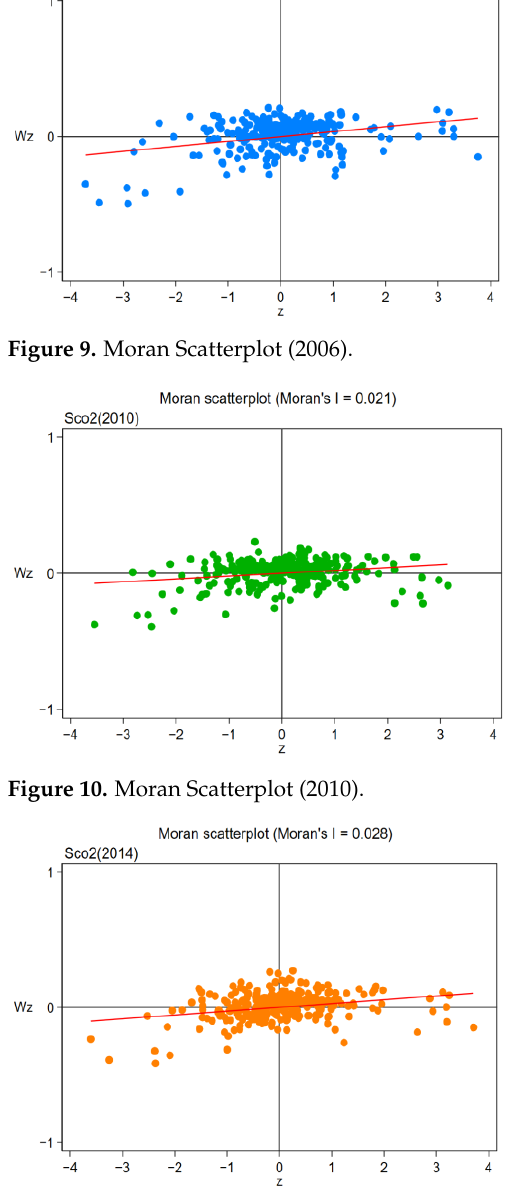
Figure 12. Moran Scatterplot (2019).